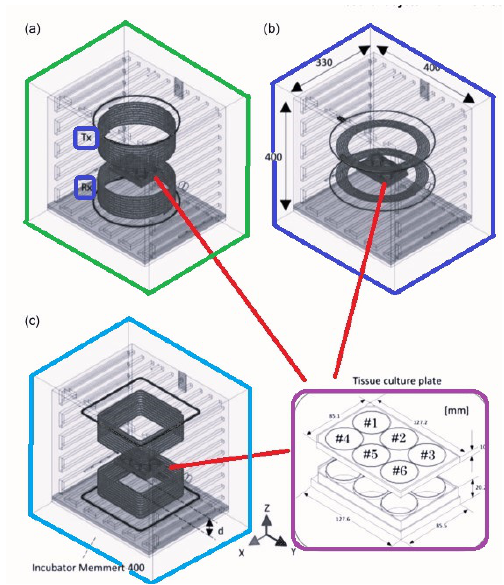
Figure 20. WPT exposure systems of different loops/coils geometries optimized according to the methodology for a 10 cm distance between Tx and Rx coils providing a maximized transfer efficiency greater than 90% at the frequency of interest: ( a ) cylindrical with circular cross-section, ( b ) annular, ( c ) cylindrical with square cross-section.